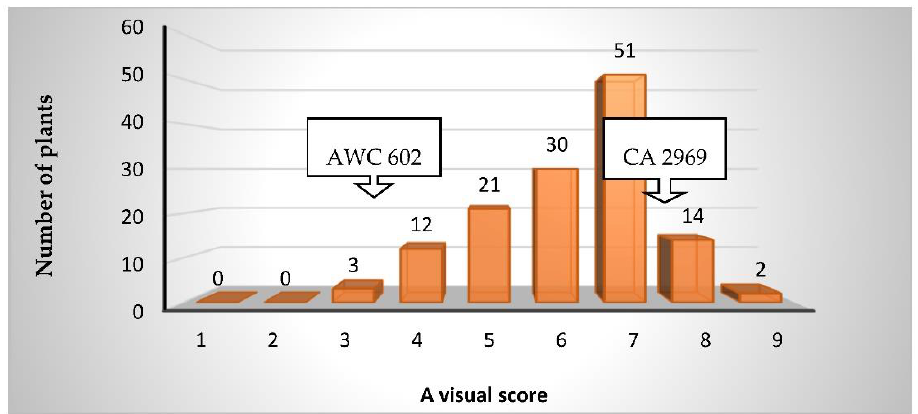
Figure 2. Distribution of RILs derived from interspecific crosses between C. arietinum and C. reticu- latum , on the basis of number of plants as resistant or susceptible to the leafminer. Table 2. Means, standard errors (SE) and ranges for resistance to the leafminer and agro-morphological traits, and corre- lations between RL and agro-morphological traits in RILs derived from interspecific crosses between C. arietinum and C. reticulatum.